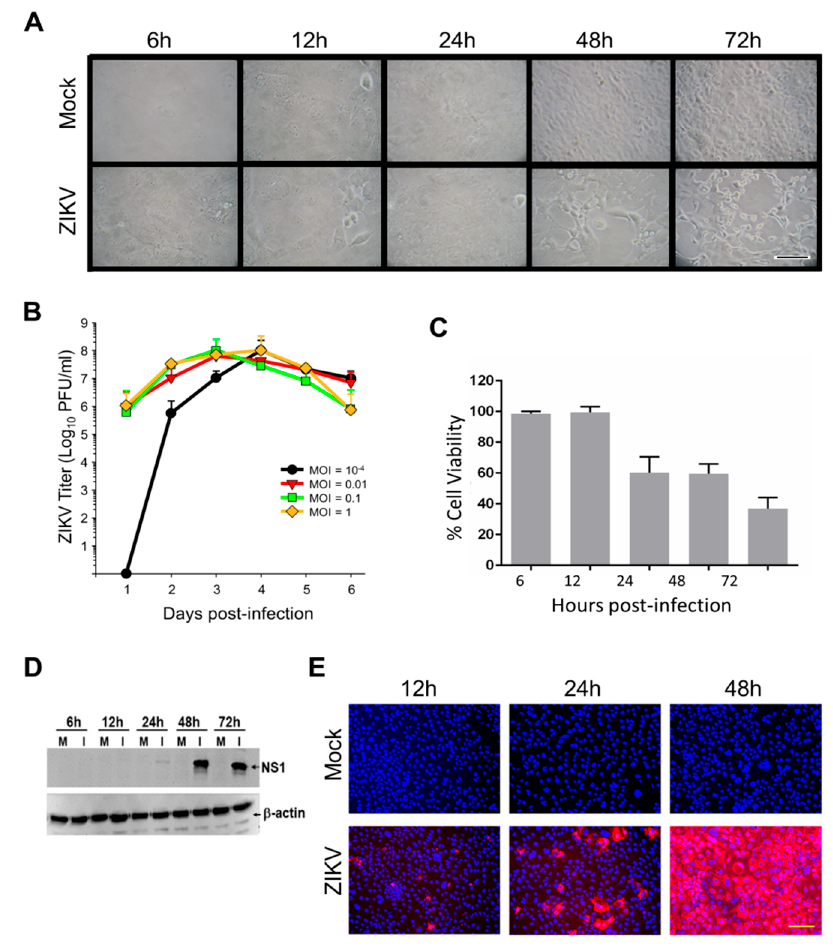
Figure 1. ZIKV growth kinetics in Caco-2 cells and proteomic validation. ( A ) Photomicrographs of Mock and Zika virus (ZIKV) infected Caco-2 cells at indicated times post-infection. ( B ) Kinetics of virus production after di ff erent MOI infections. Error bars represent S.E.M. of three replicates. ( C ) Cytopathology induced at di ff erent times post-infection, determined by WST-1 cell viability. Error bars represent S.E.M. of three replicates. ( D ) ZIKV non-structural protein-1 (NS1) expression in mock-infected (M) and in virus-infected (I) cells. ( E ) Immunofluoresence staining showing expression of ZIKV NS1 protein (red) as a function of time after ZIKV MOI = 3 infection. Nuclei were stained with DAPI (blue). Scale bars in A and E , (lower right micrographs) represent 100 µ